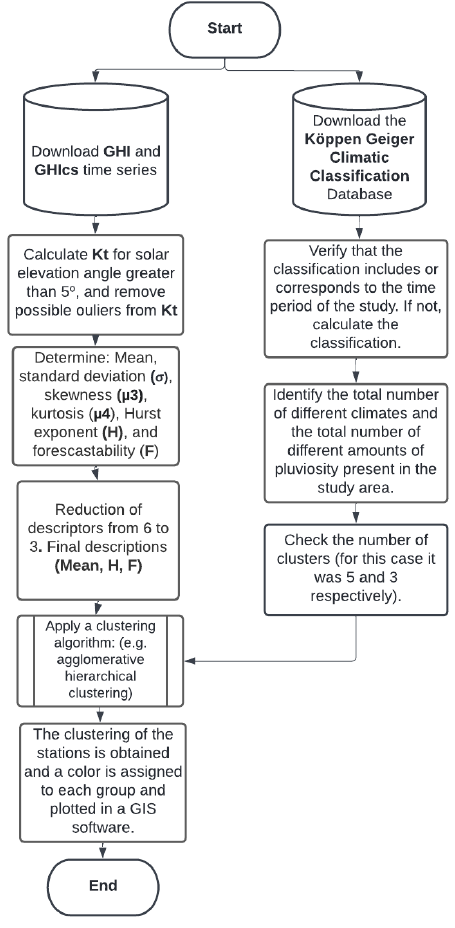
Figure 20. Various steps of the methodology.